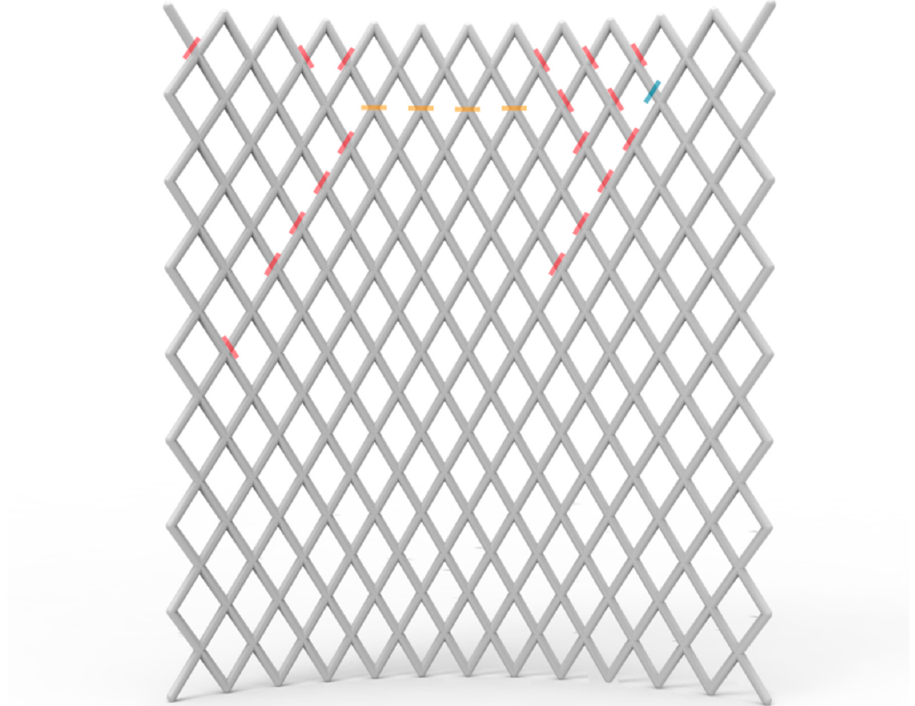
Figure 13. Net in unrolled representation: Location of failure pattern on geometrical notches (red), on printing misalignments along printing layers (orange) and on topological notches (blue).